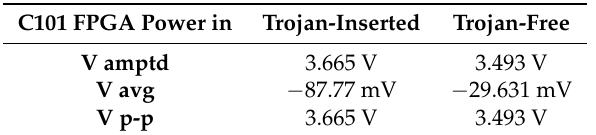
Table 2. Results of C101 Capacitor.